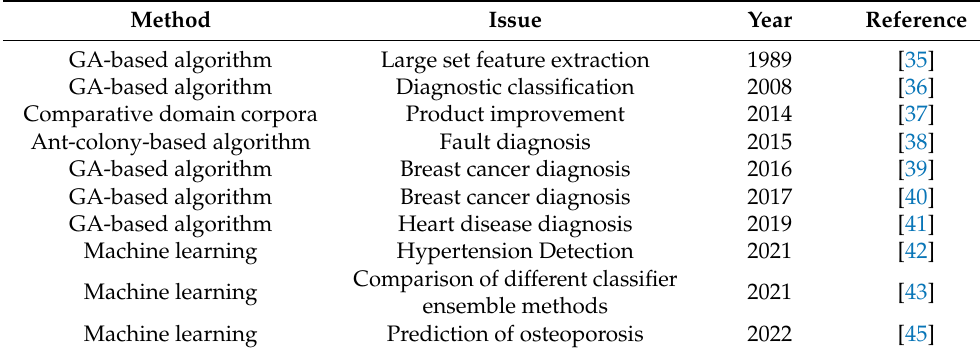
Table 1. Comparison of previous research on feature